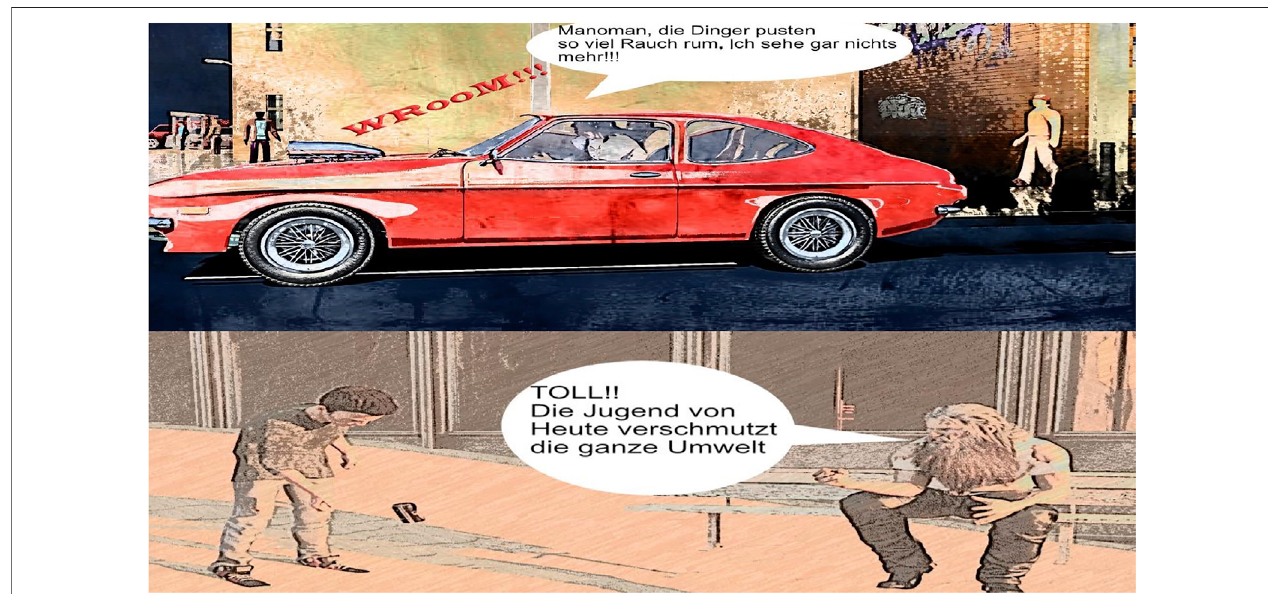
FIGURE5| Usingphotographsforaconvincing representation ofapossibleworld.Theauthoraimsatrepresentinggeographical spaceasacontainerwhile atthe same time merging it with perceived space. The text in the speech bubbles reads: “ Wow, those things produce so much smoke, I can hardly see anything!!! ” , and “ Just perfect! The kids nowadays pollute the entire environment ” . Image courtesy of M.